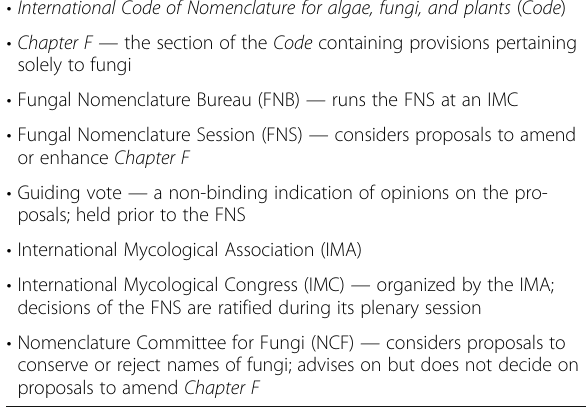
Table 1 Key organizations and events related to the governance of fungal